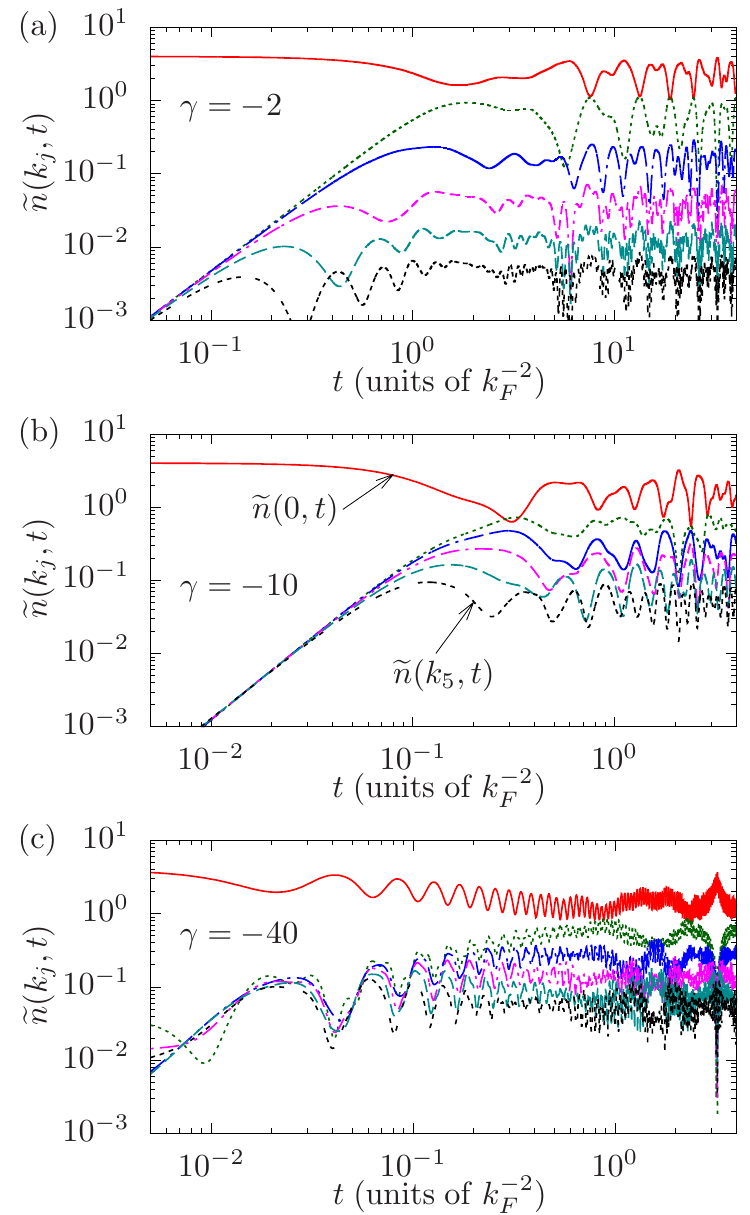
n ( k , t ) of the first six nonnegative (cid:101) j